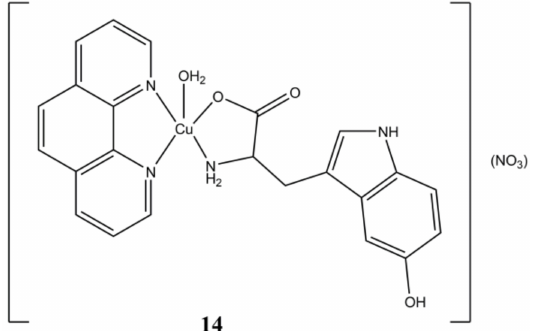
Figure 14. Structure of [Cu(5HTP)(phen)(H 2 O)](NO 3 ).